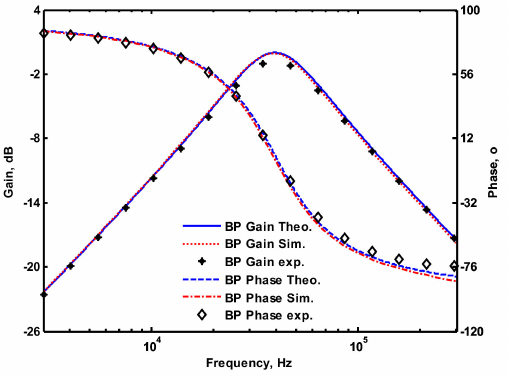
Figure 8. Simulation and experimental results of BP filtering responses at V o2 when V i1 = V in and V i2 = 0.